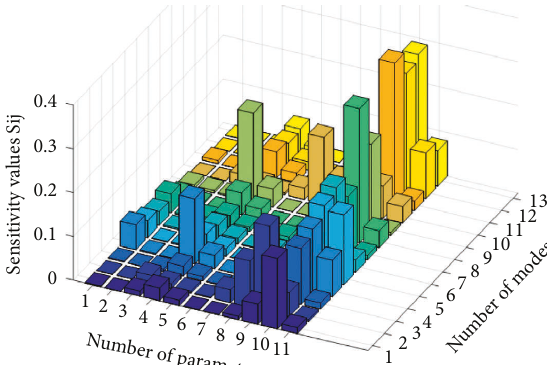
Figure 13: The sensitivity analysis of the selected parameters. Table 9: Comparison of the experimental and numerical data for the updated FE models with four parameters.